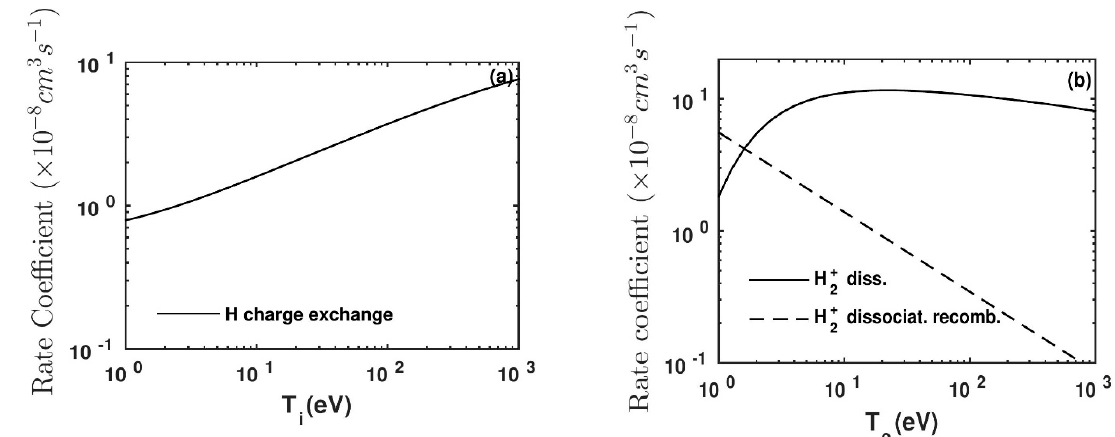
Figure 7. ( a ) H + -H charge-exchange reaction rate coe ffi cient and ( b ) electron impact reaction rate Figure 7. (a) H + -H charge-exchange reaction rate coefficient and (b) electron impact reaction rate coe ffi cients for reaction (see, Table 1) XI and coefficients for reaction (see, Table 1) XI and XVI